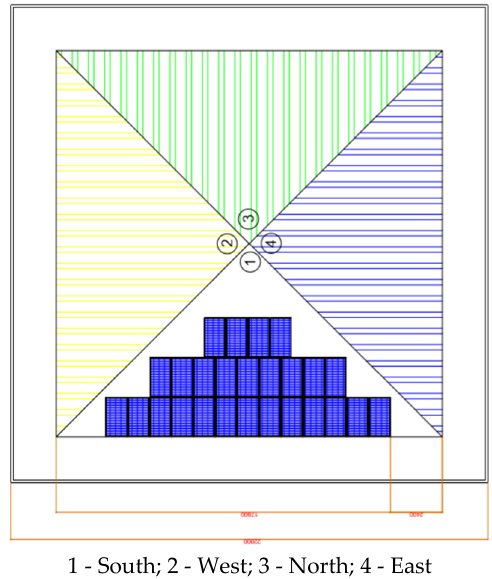
Figure 5. Rooftop solar panel layout in AutoCAD.